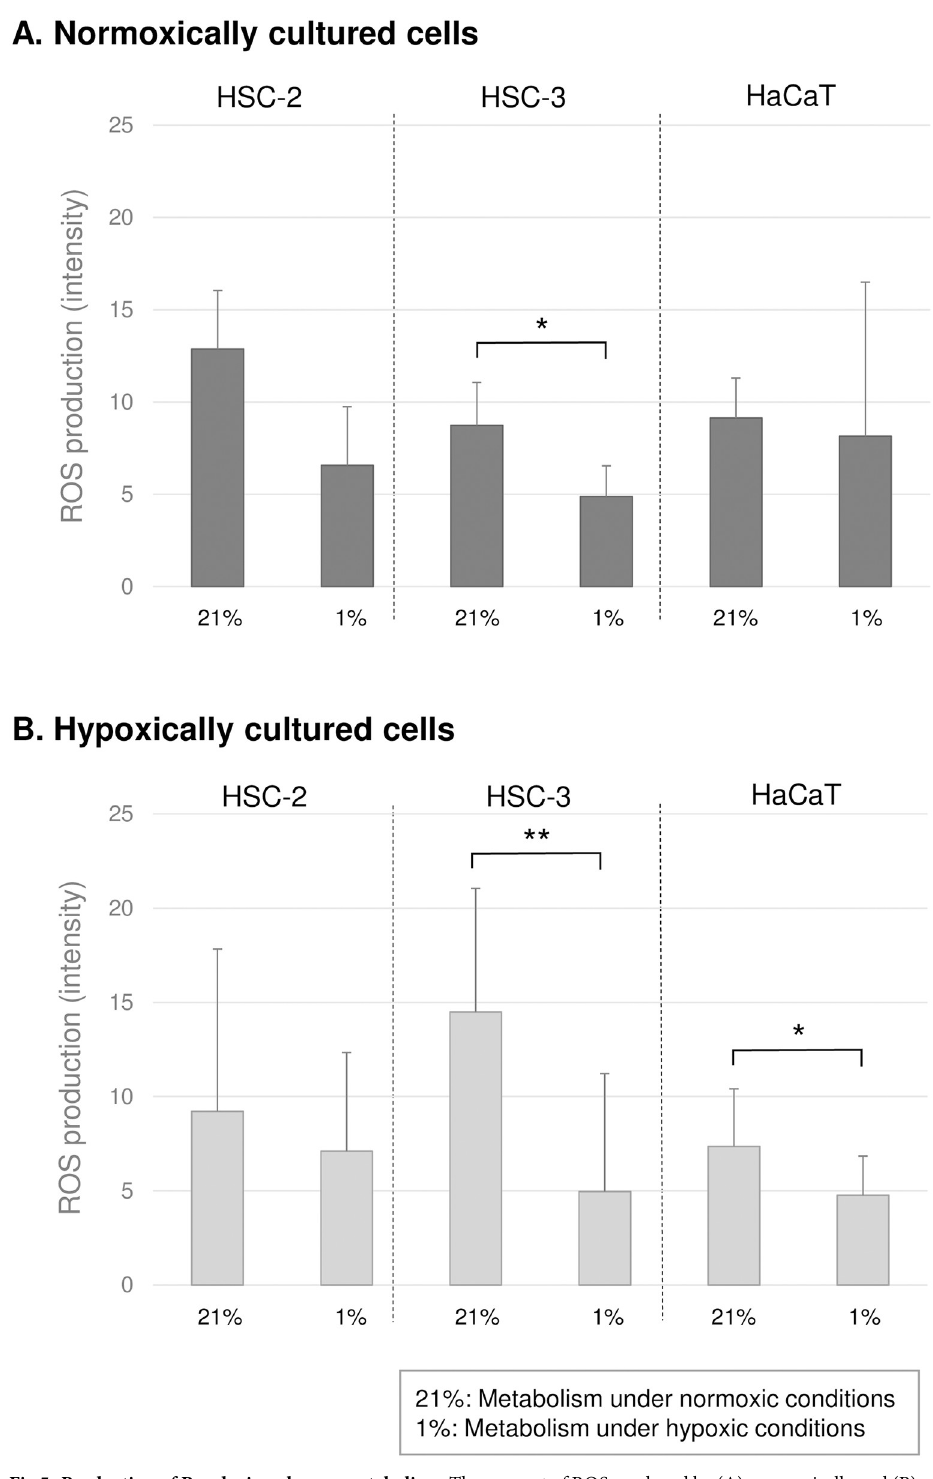
Fig 5. Production of Ros during glucose metabolism. The amount of ROS produced by (A) normoxically and (B) hypoxically cultured cells was estimated by ROS assay kit. Cancer cells were harvested after 3-day culture and normal cells were harvested after 5-day culture. The error bars represent standard deviation. Significant difference ( � , p < 0.05; �� , p < 0.001) in the amount of other acids produced between normoxic and hypoxic conditions, according to the paired